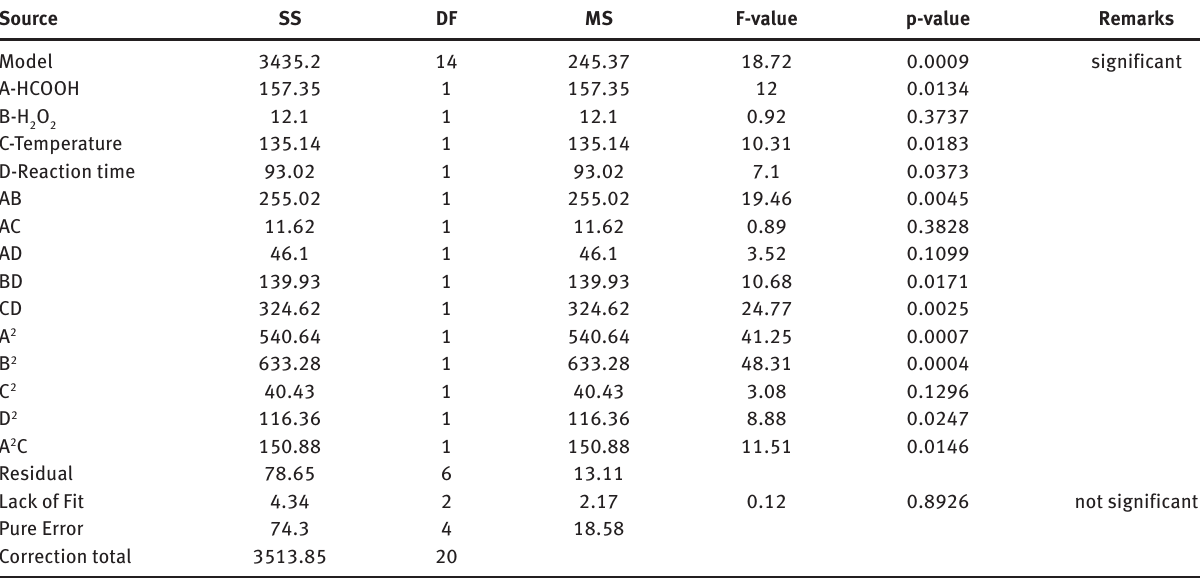
Table 5: ANOVA for the CCD of the reduced cubic model for sulphur removal.